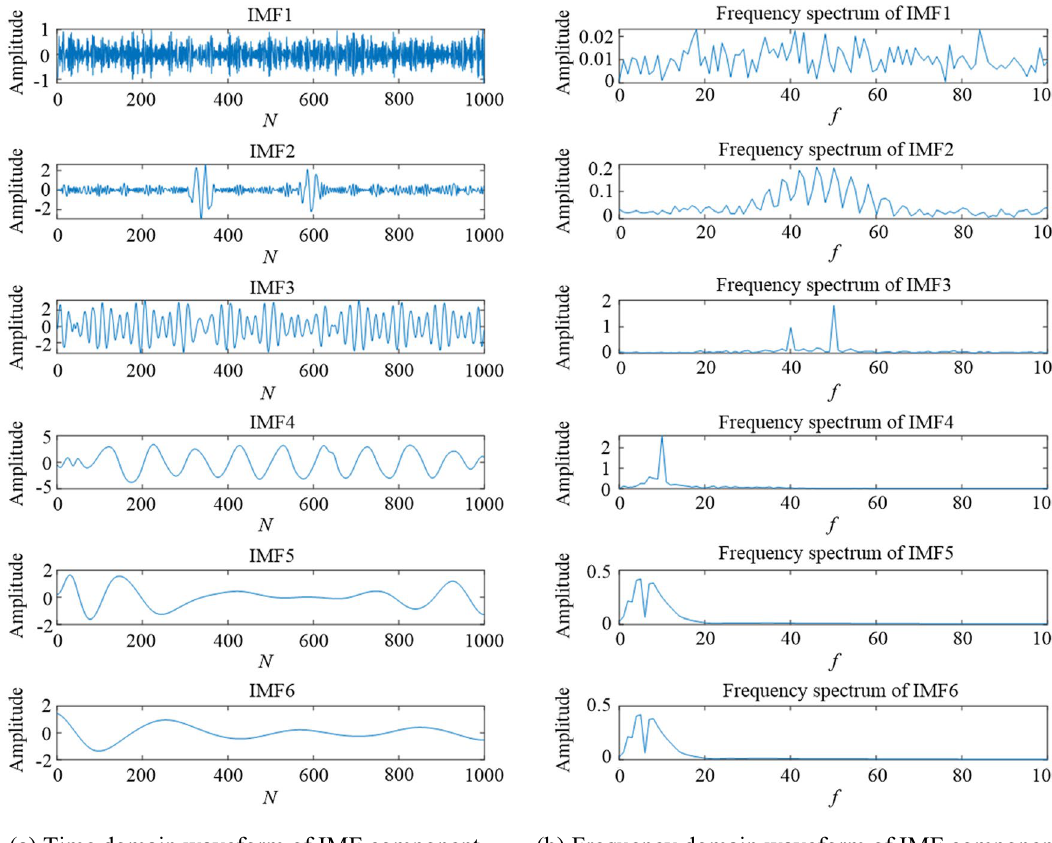
Figure 13. The component waveforms after EMD processing.